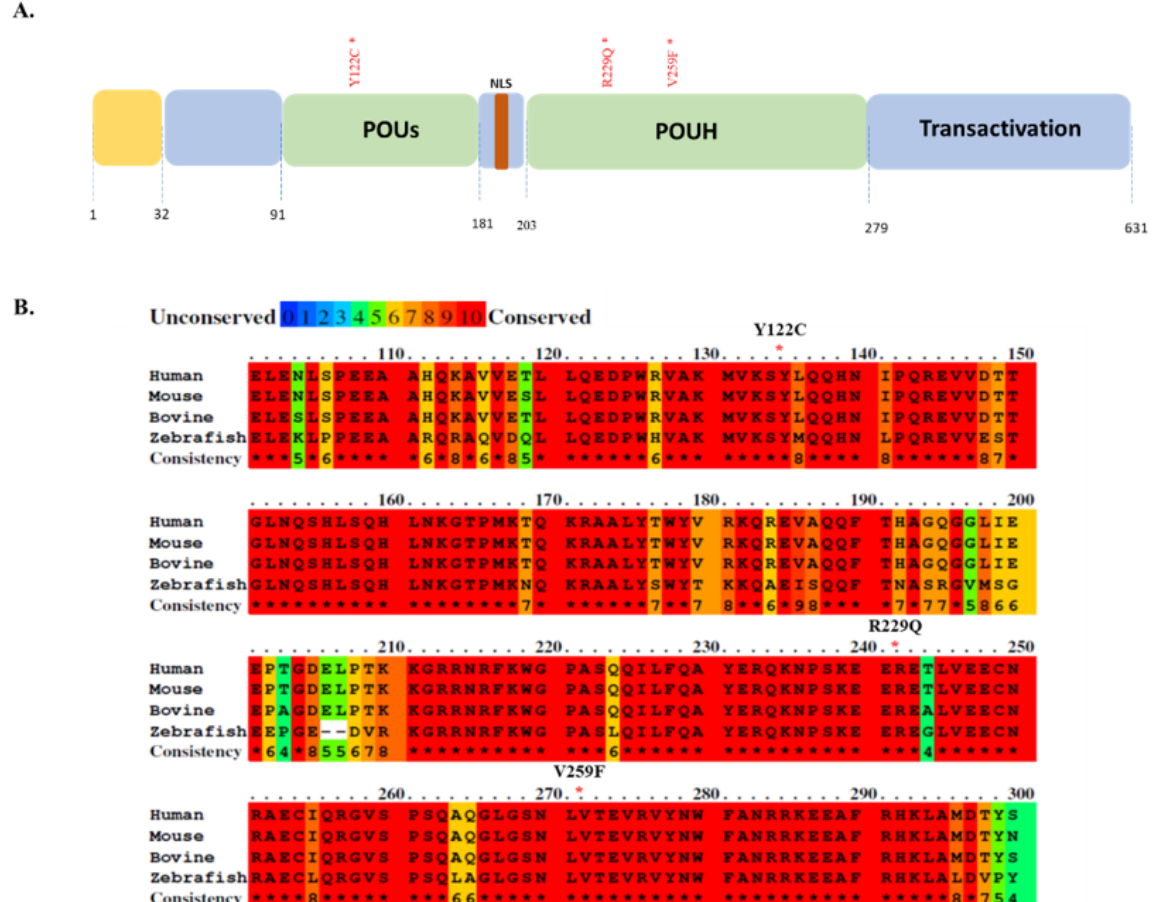
Figure 1. ( A ) Positions of novel mutations are indicated in the human HNF1A protein structure (Pit1, Oct1 and Unc1 (POU) domain-Green; POU homeodomain (POUh) and POU-specific (POUs)). ( B ) Alignment of the human, mouse, bovine and zebrafish HNF1A amino acid sequences and mutations found in the POU domain. Red color denotes highly conserved (100%) elements among the species. The mutations (indicated by red asterisks) in the POU domain of HNF1A are highly conserved in species.